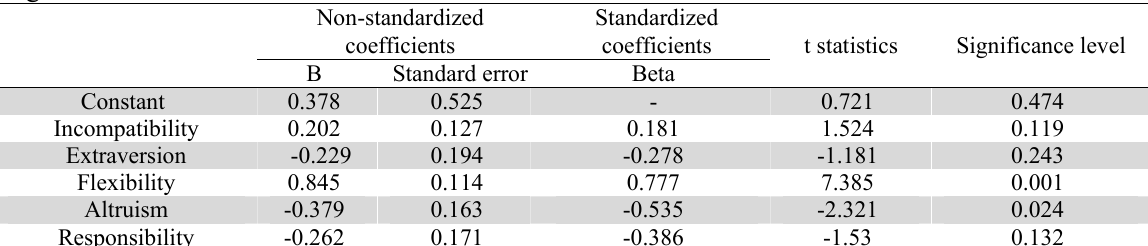
Regression coefficients